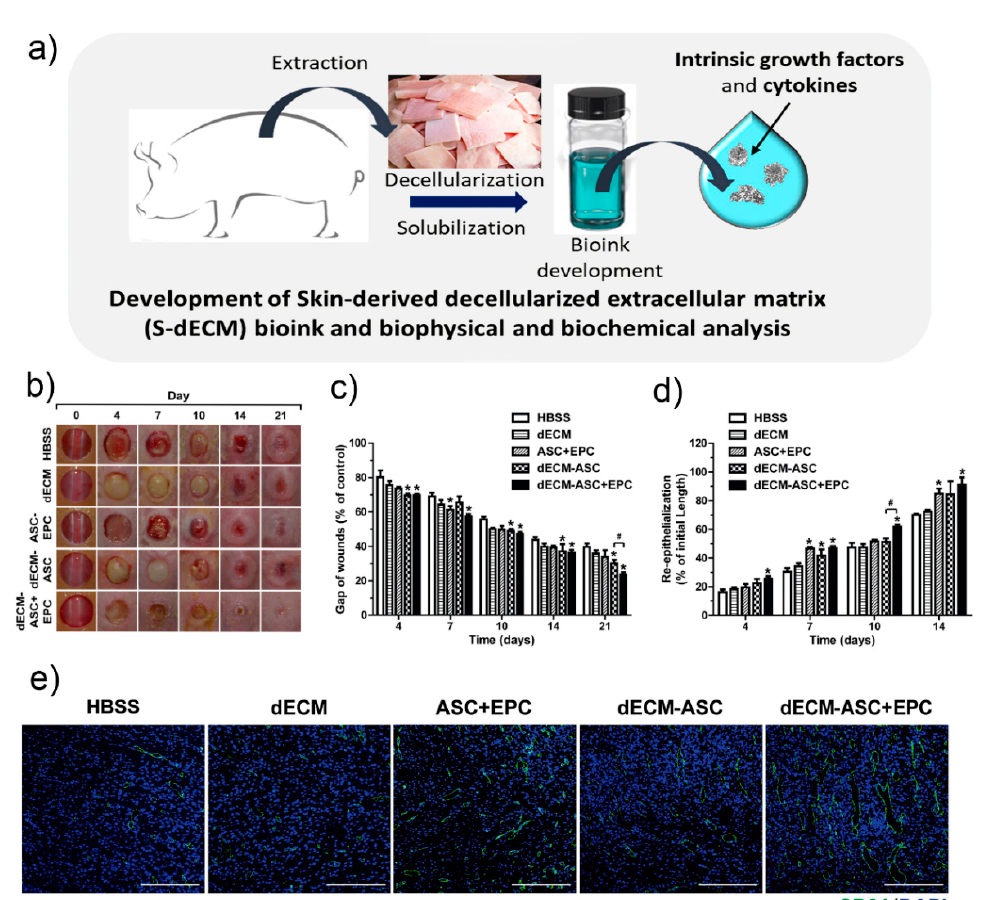
Figure 6. Kim et al.’s 3D cell printing of in vitro stabilised skin model and in vivo prevascularised skin patch using tissue-specific extracellular matrix bioink. ( a ) Development of decellularised extra cellular matrix bioink. ( b ) Representative photographs during 21 days of wound healing. ( c ) Variations of wounds gaps. ( d ) Re-epithelialisation values in the wounds areas on various days during wound healing. Data indicate mean ± SD. * p < 0.05 versus Hank Balanced Salt Solution (HBSS), # p < 0.05 versus dECM-ASC (skin equivalent composed of derived extracellular matrix and containing adipose-derived mesenchymal stem cells ( n = 8–11). ( e ) In vivo vascularisation evaluation. Representative photographs of skin wound tissues on day 7 after immunostaining with anti-CD31 (green). Image reproduced with permission from Kim et al. [115]. Copyright 2018